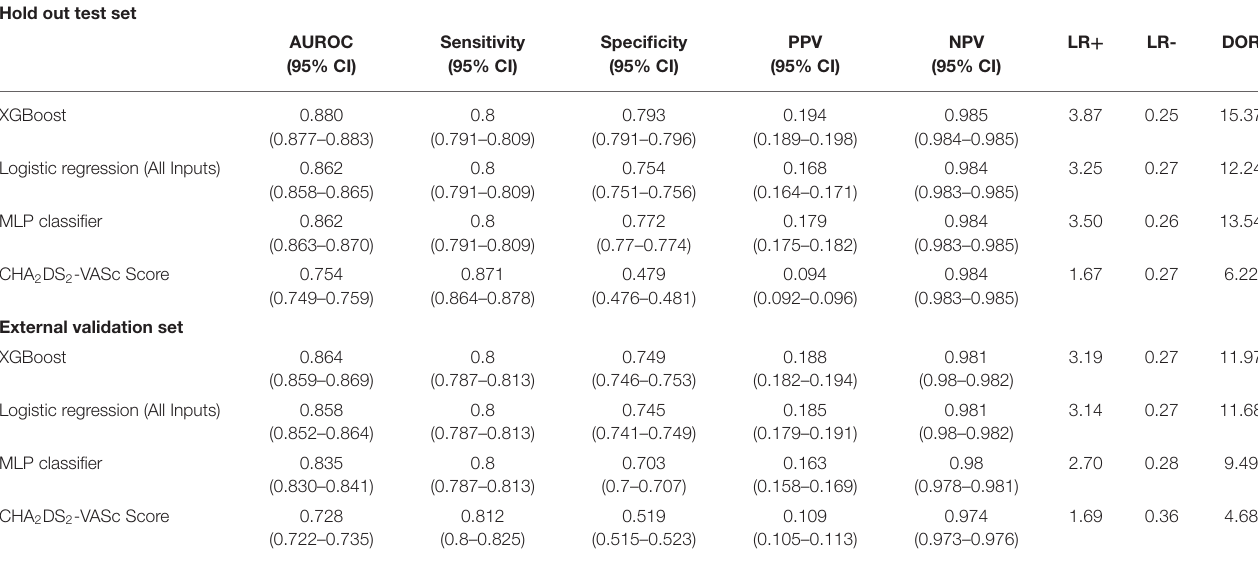
TABLE 5 | Performance metrics for XGBoost, logistic regression, and multilayer perceptron (MLP) machine learning algorithms (MLAs) on the testing set and external validation set in comparison to the CHA 2 DS 2 -VASc risk score. Hold out test